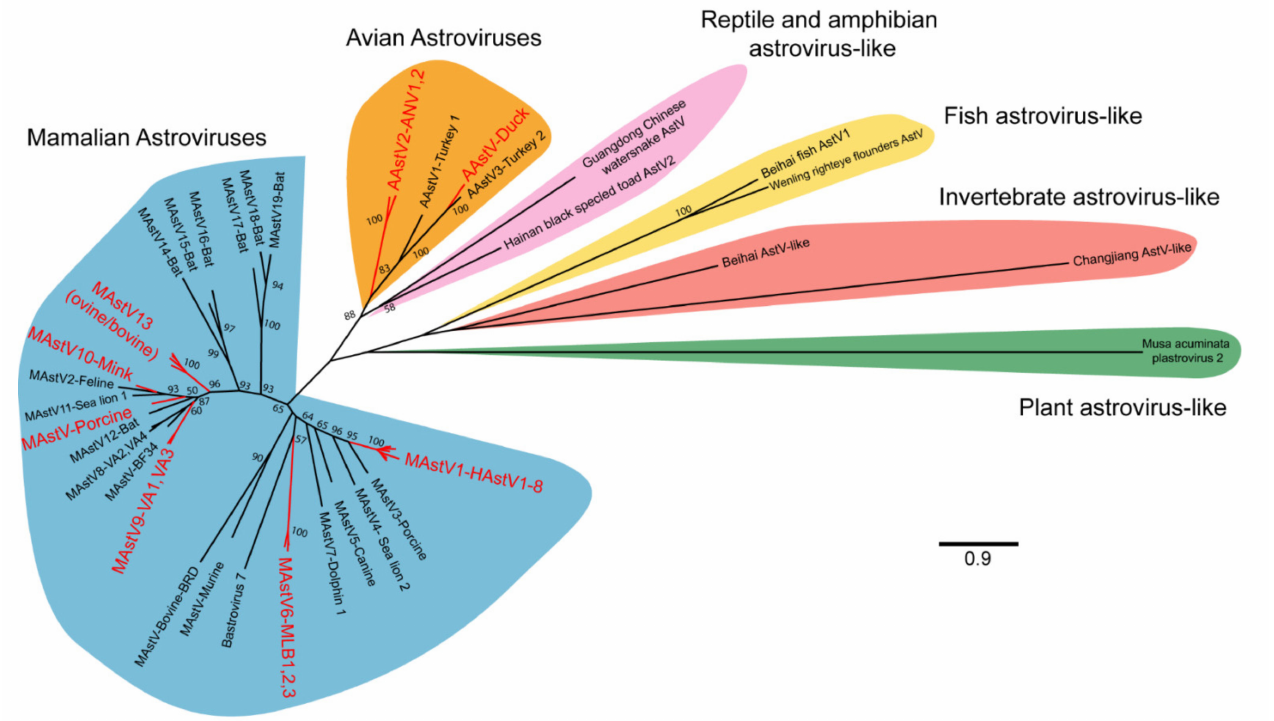
Figure 2. Phylogenetic relationships of representative astrovirus ORF2 sequences. A total of 53 astrovirus genomes were selected for analysis and include the 22 astrovirus species recognized by ICTV, genotypes implicated in extraintestinal diseases, and recently identified representative reptilian, amphibian, fish, invertebrate, and plant astrovirus-like genomes (see Supplementary Materials for full list). Astrovirus amino acid sequences for ORF2 were aligned using MUSCLE and noninformative alignments removed by TrimAI [10,11]. A maximum likelihood tree was generated in MEGA X, using the LG model with frequencies and discrete gamma distribution [12]. A total of 100 bootstraps were completed with bootstrap values >50 represented on the tree. Astrovirus clades that have been implicated in extraintestinal diseases are highlighted in red. MAstV: mamastrovirus; AAstV: avastrovirus; HAstV: human astrovirus; AstV: